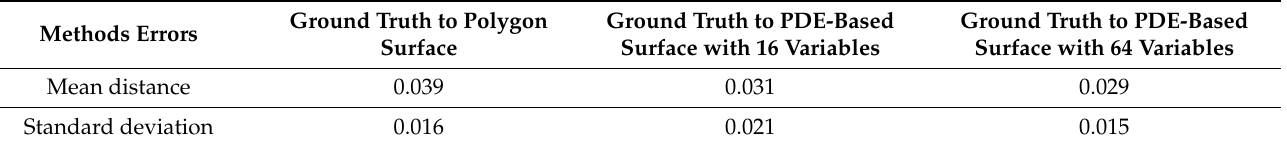
Table 1. The mean distance and its standard deviation between the ground truth surface and the PDE-based surface with polygon-based surface, respectively.